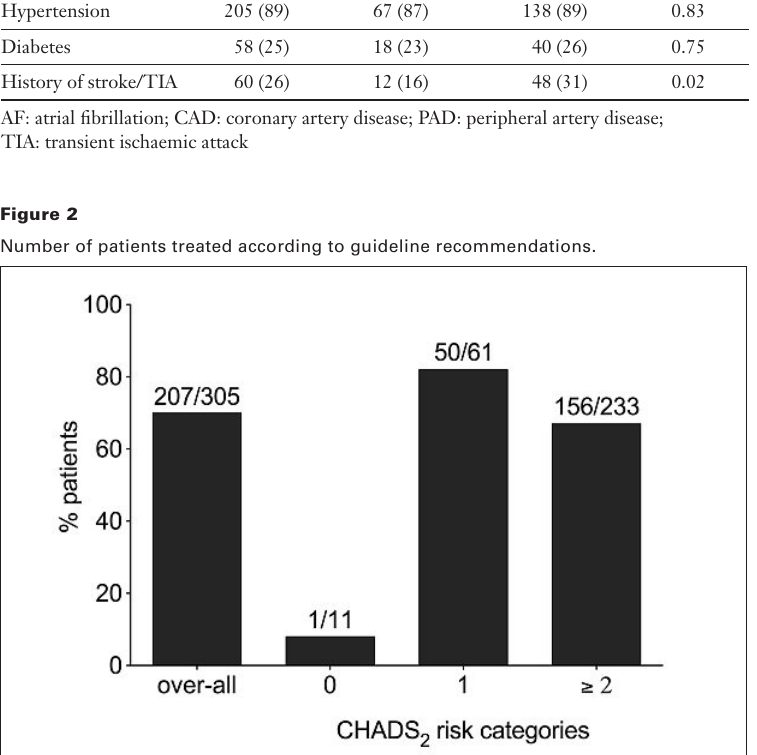
AF: atrial fibrillation; CAD: coronary artery disease; PAD: peripheral artery disease; TIA: transient ischaemic attack